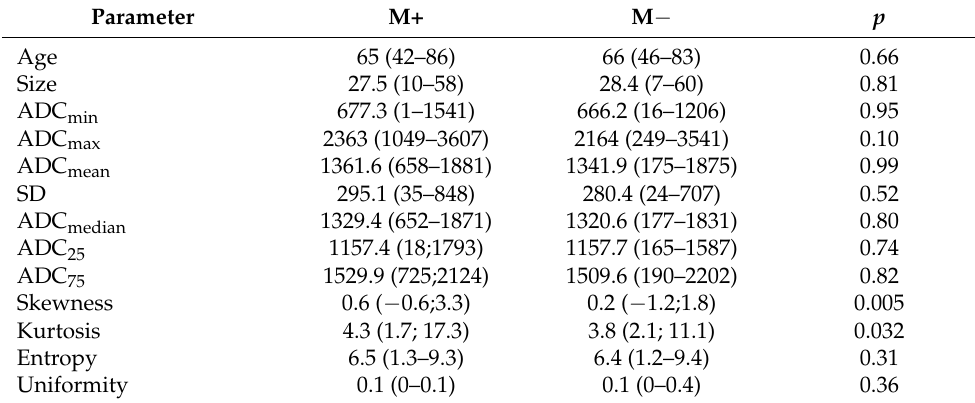
Table 3. Results of the Mann–Whitney U test for comparison of quantitative conventional MR features and histogram-derived parameters; data are mean